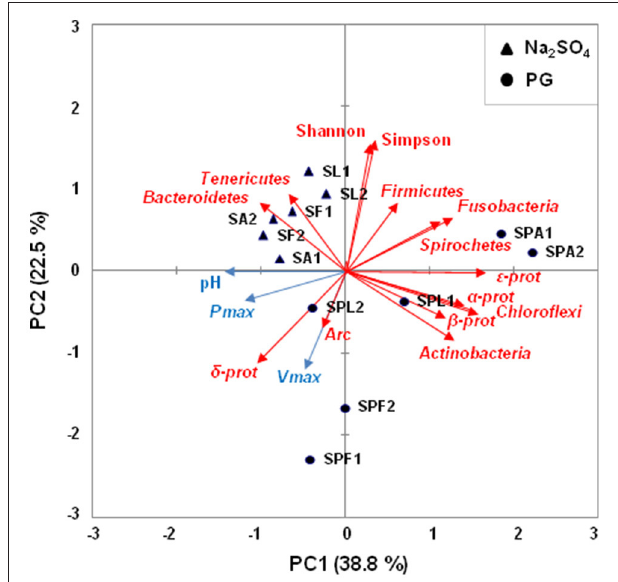
FIGURE 4 | Principal Component Analysis (PCA) biplot showing the variation among the enrichment cultures based on hydrogen sulfide production performances and the relative abundance of microbial taxa. Black circles represent PG enrichment cultures and black triangles represent Na 2 SO 4 enrichment cultures. The names of enrichment cultures (duplicates 1 and 2) have been abbreviated as follows: SF, SL, and SA, for Na 2 SO 4 enrichment cultures with formate, lactate, and acetate as electron donors, respectively; SPF, SPL, and SPA, for PG enrichment cultures with formate, lactate, and acetate as electron donors, respectively. Arrows indicate the direction of maximum increase and strength (through the length) of each variable to the overall distribution. The blue arrows are indicators of hydrogen sulfide production (pH, P max , V max ) and the red arrows represent the microbial taxa. Among these latter, α -Prot, β -Prot, δ -Prot, ε -Prot stand for Alphaproteobacteria , Betaproteobacteria, Deltaproteobacteria, and Epsilonproteobacteria . The first two principal axes explained 61.3% of the